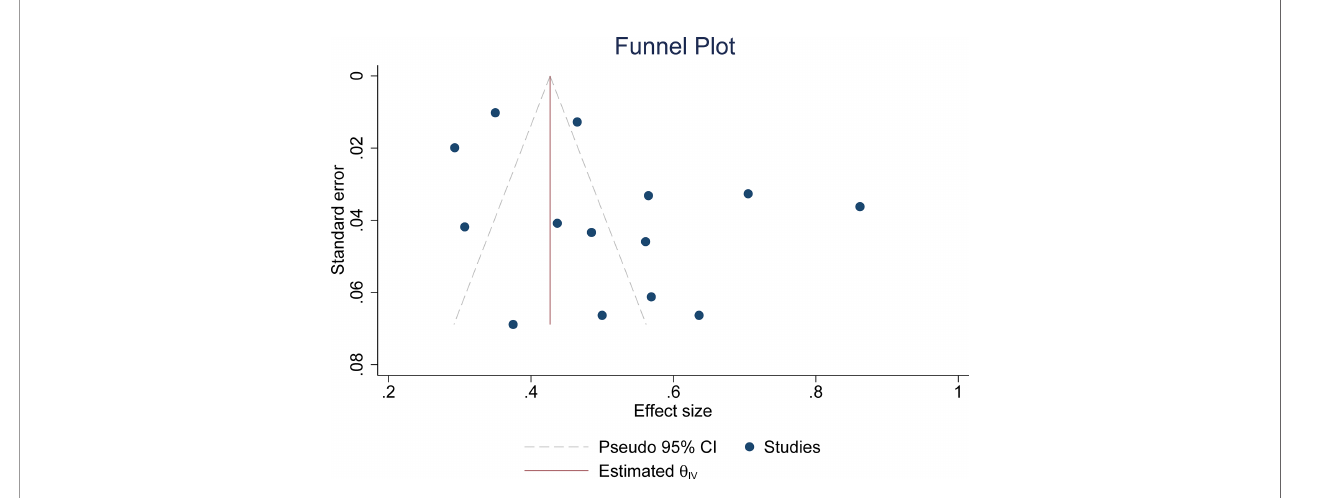
FIGURE 4 | The funnel plot for testing publication